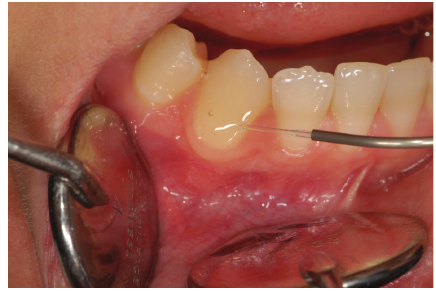
Figure 3: NaF gel application (Group 1).